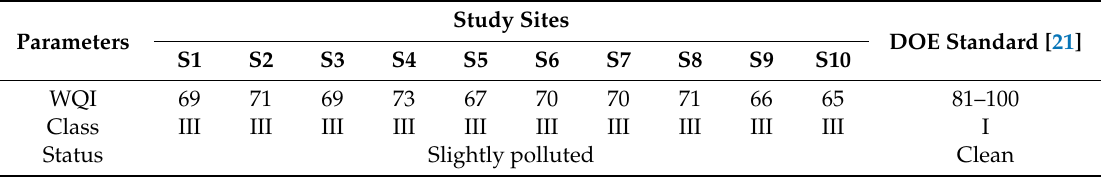
Table 6. WQI and class water of Bintulu, Sarawak rivers in Borneo.